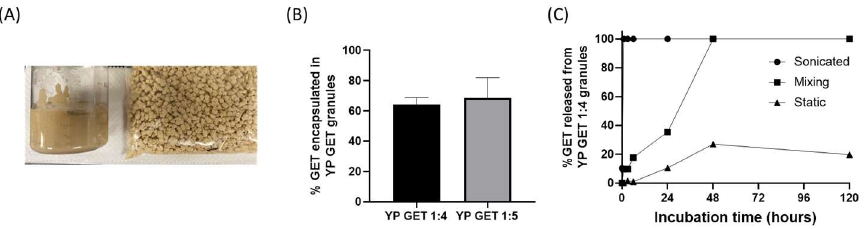
Figure 5. ( A ) Picture of homogenized aqueous suspension of YP GET 1:4 and YP GET 1:4 granules, ( B ) encapsulation efficiency of GET 2:1:2 in YP GET granules, and ( C ) GET release from YP GET 1:4 granules suspended in water at 1 mg GET/mL at room temperature under three incubation conditions.